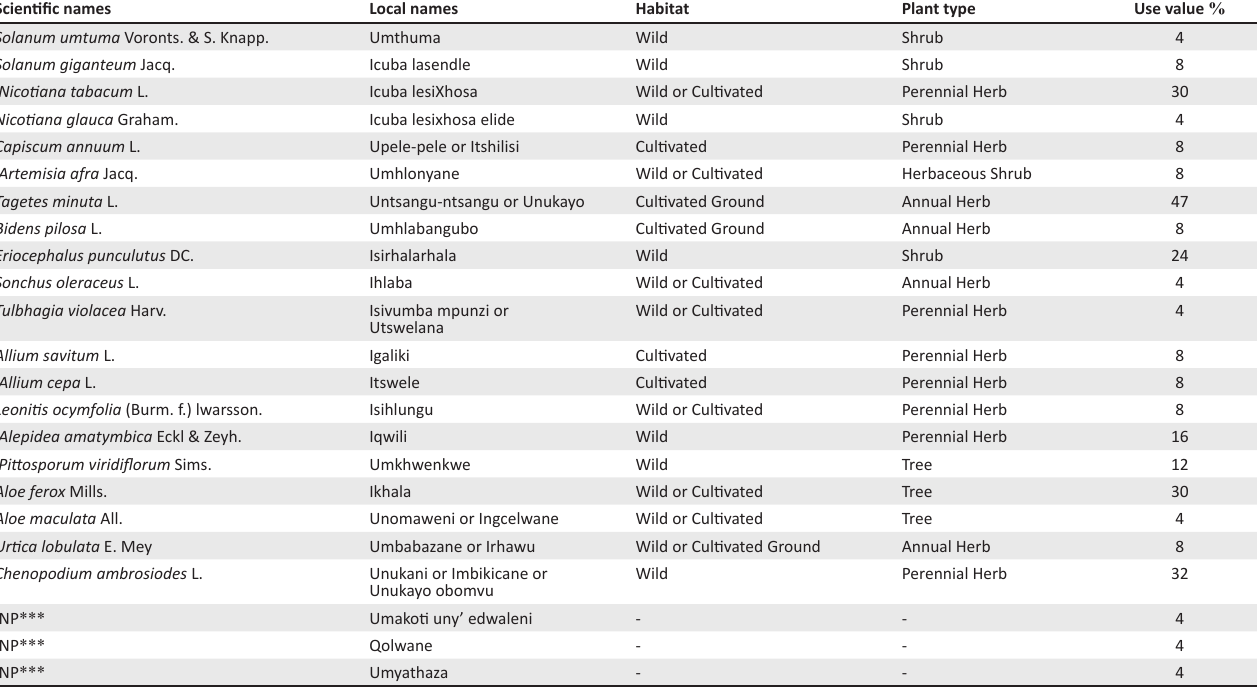
TABLE 2: Plants identified and used by farmers for pest control in cabbage. Scientific